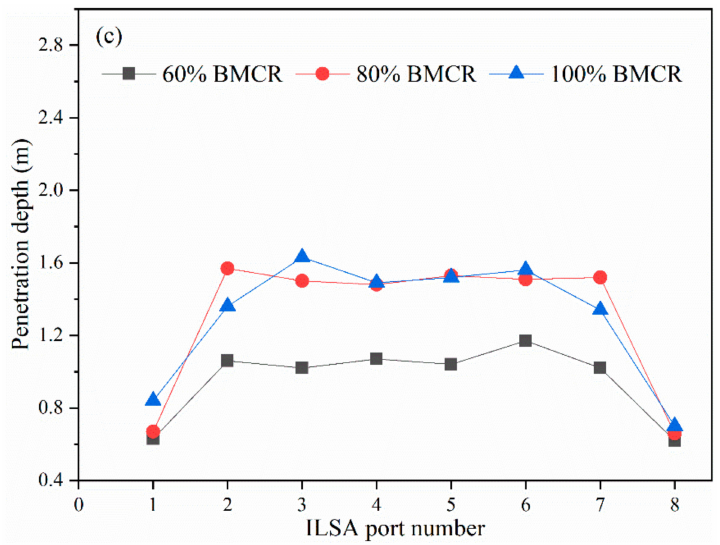
Figure 13. Distributions of SA penetration depth under different boiler loads (( a )—OUSA ports; ( b )—IUSA ports; ( c )—ILSA ports).